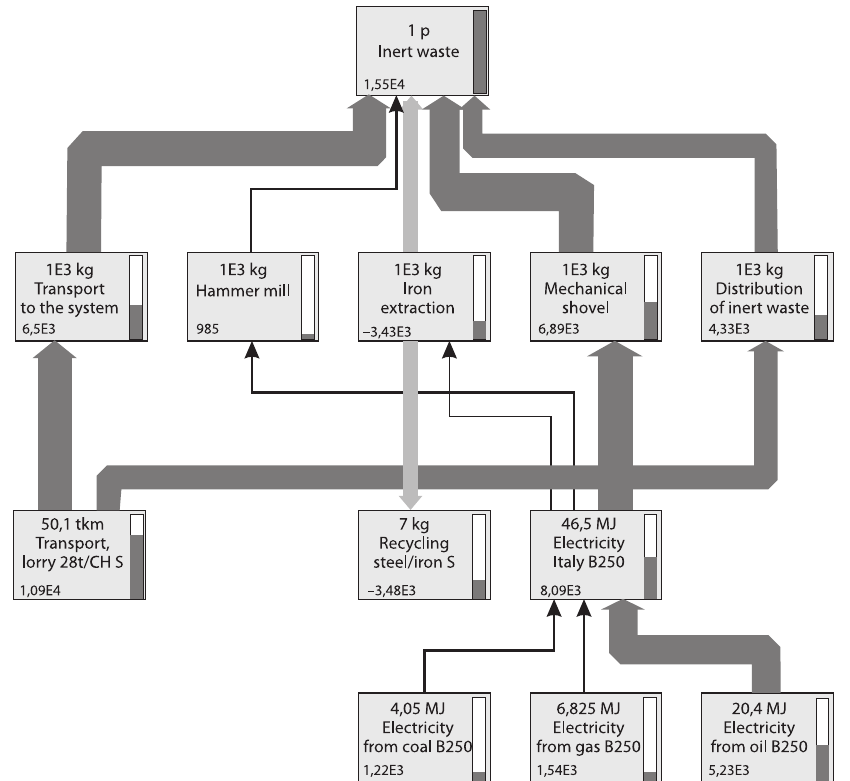
Fig. 14. Mass balance flow sheet (Sankey diagram) for CO recycling/reuse, associated to GWP impact category